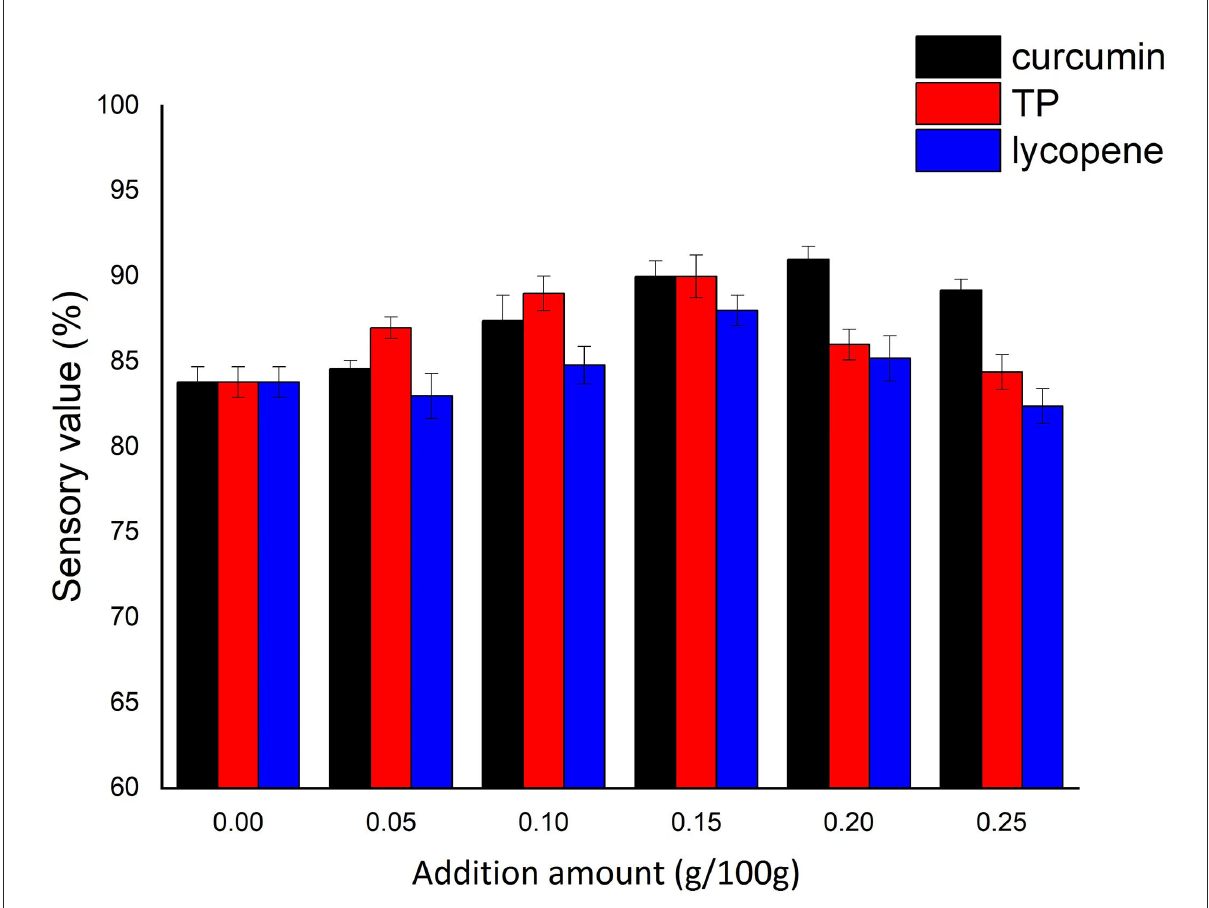
FIGURE3 Effect of additional amount of NAs on the sensory value of